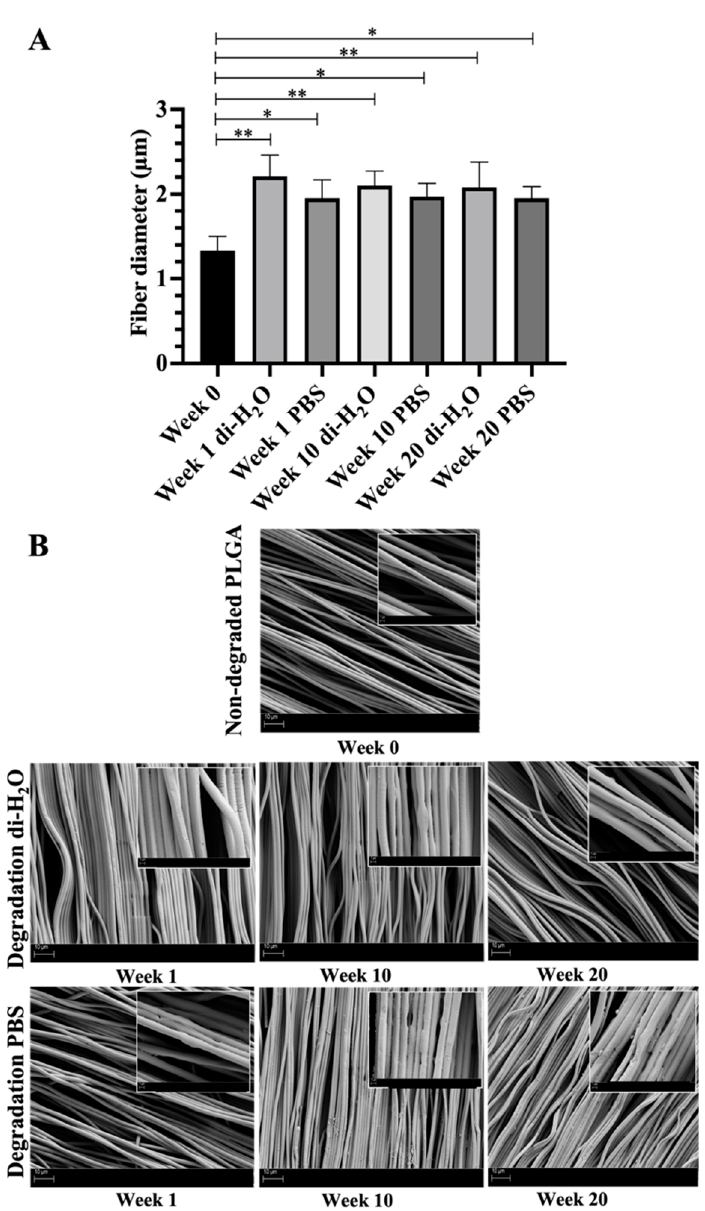
Figure 1. ( A ) Histogram showing the different fiber diameter sizes of the undegraded and degraded PLGA scaffolds at different time points. * and ** statistically between PLGA week 0 (non-degraded) and the PLGA scaffolds at different degradation time points ( p < 0.05 and p < 0.01, respectively). ( B ) SEM investigations (5 kV, 10 μ m) of the electrospun PLGA scaffold surface subjected to degradation under di ‐ H 2 O and PBS at weeks 0, 1, 10, and 20. The inset in each image shows the same sample at higher magnification (5 kV, 1 μ m).